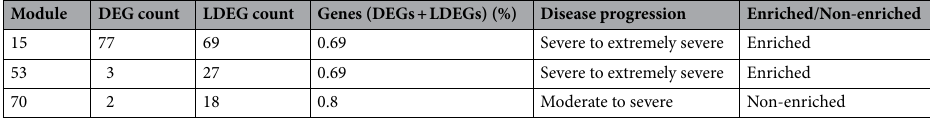
Table 2. Module with over 65% genes displaying perturbed expression in severe SARS-CoV-2 infected humans relative to moderate and extremely severe SARS-CoV-2 infected humans relative to